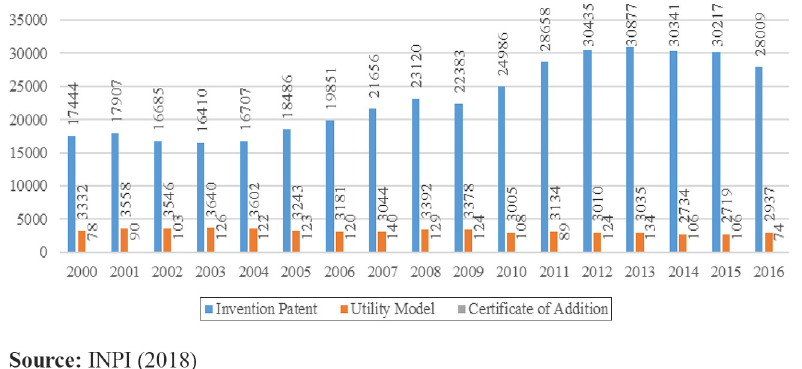
Figure 1. Evolution of